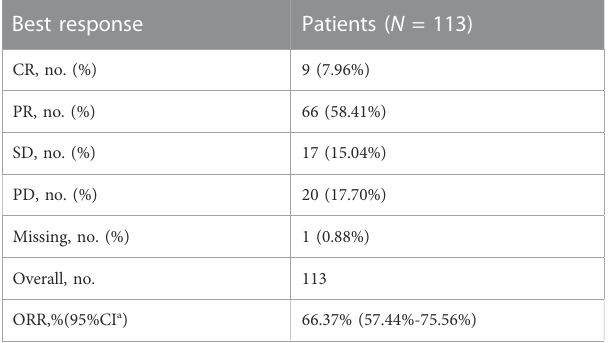
TABLE 2 Response rate and disease progression in 113 patients treated with pyrotinib. Best